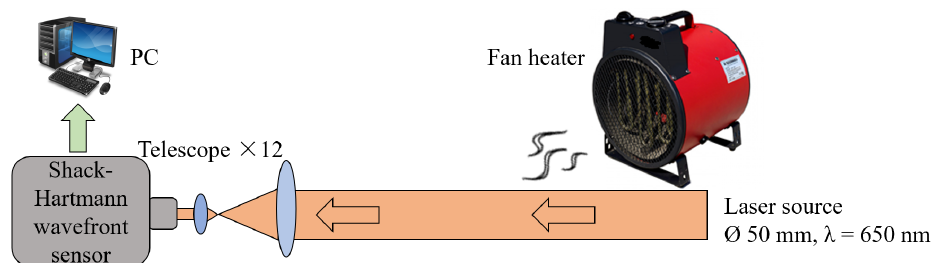
Figure 2. Experimental setup for wavefront statistical characteristics investigation.